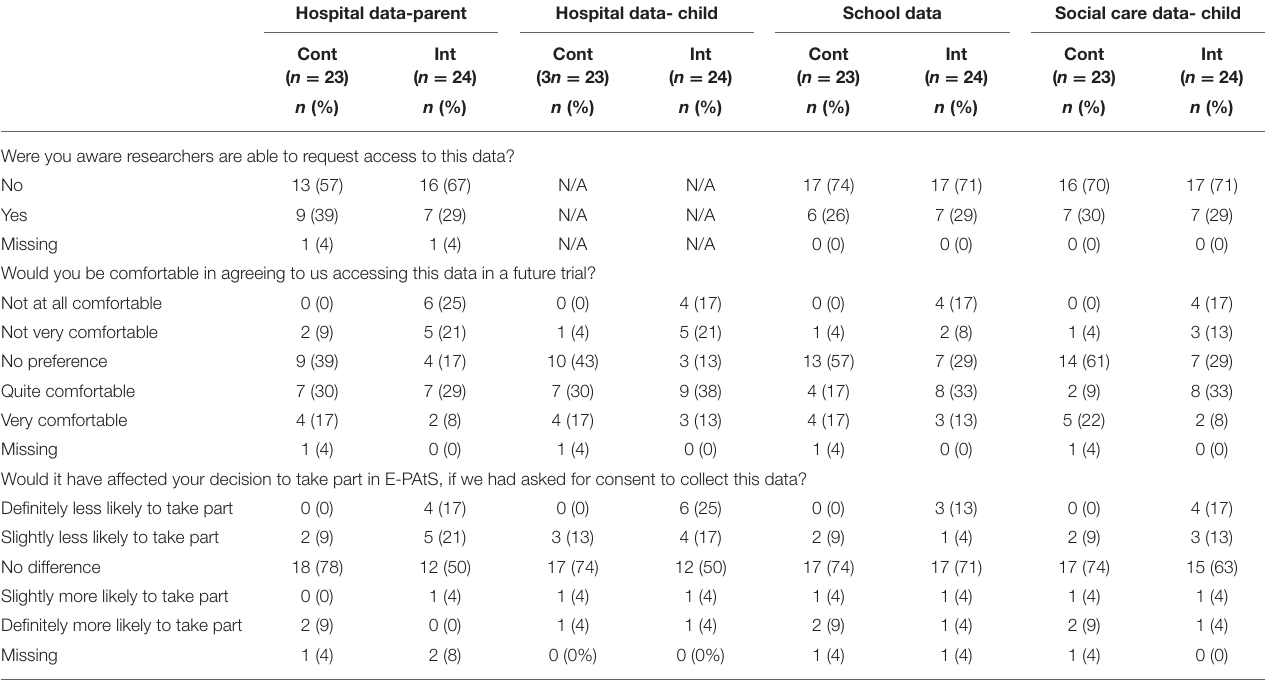
TABLE 8 | Participants’ awareness of and views surrounding routine data collection. Hospital